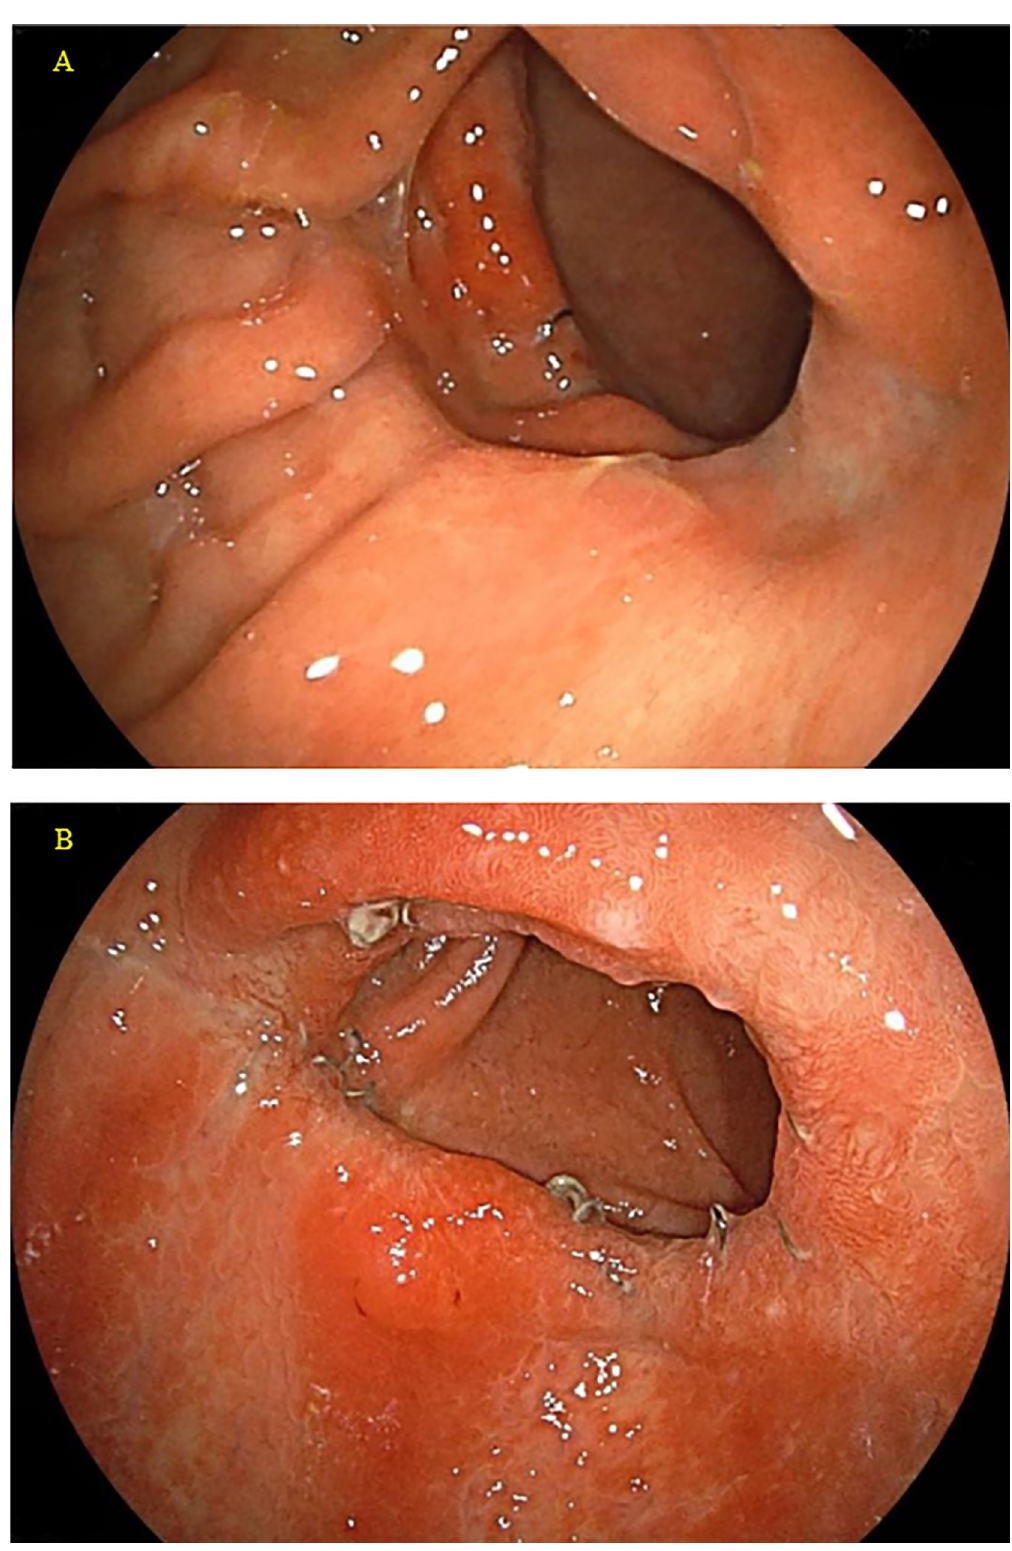
Fig 9. Endoscopic views of the gastroduodenostomy in the patients with a staple length of 30 mm. A Endoscopic view 11 months after the operation in Case 31. B Endoscopic view 4 months after the operation in Case 35.